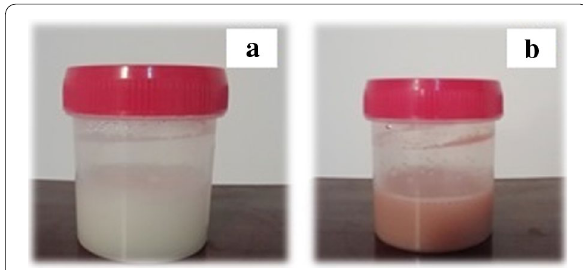
Fig. 2 Initial mixed solutions of RJ and AgNO 3 before ( a ) and after incubation ( b